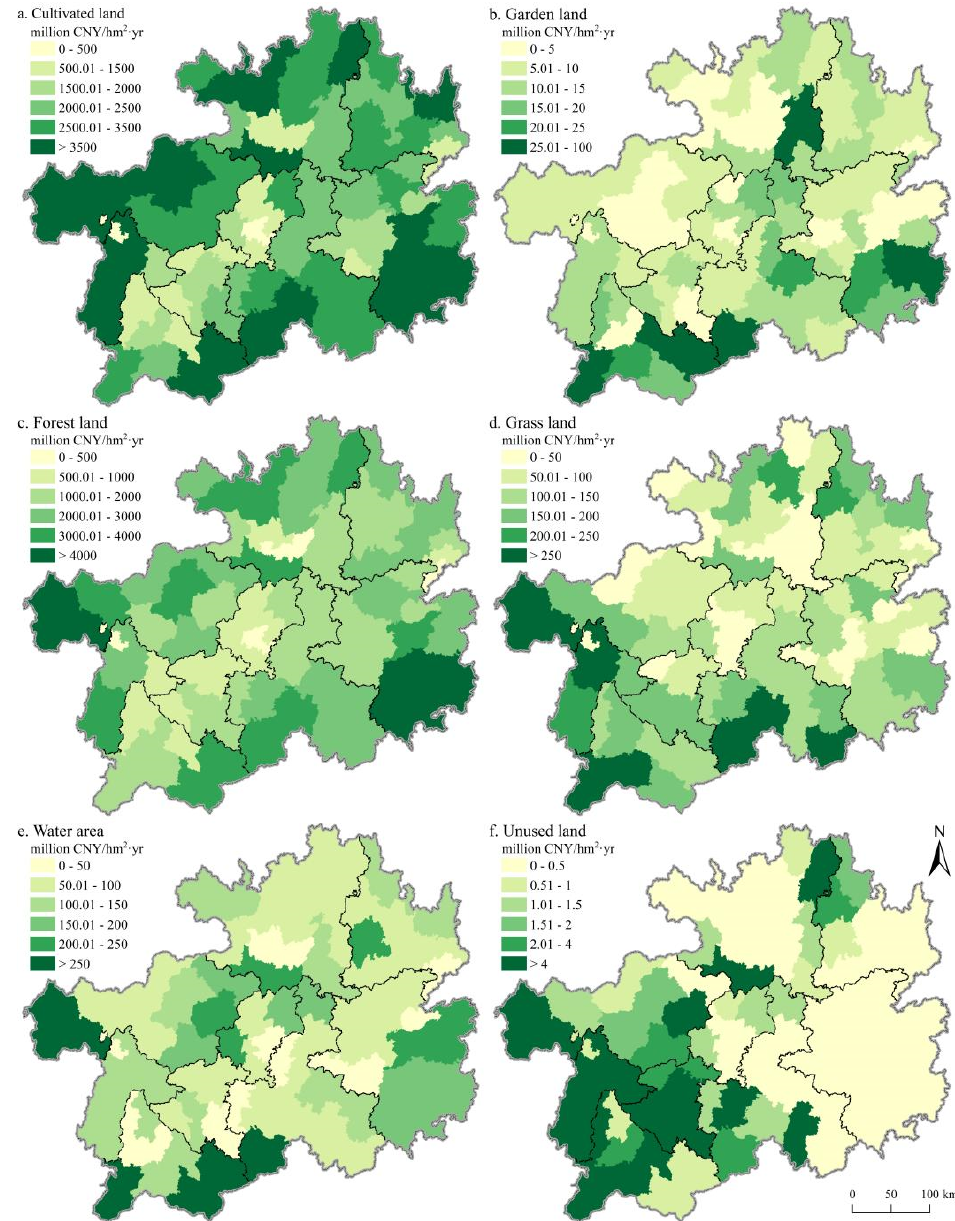
Figure 4. Spatial distribution characteristics of ecosystem services value of different land use types in Guizhou in 2018. Notes: ( a ) the spatial distribution characteristics of ecosystem services value of cultivated land; ( b ) the spatial distribution characteristics of ecosystem services value of garden land; ( c ) the spatial distribution characteristics of ecosystem services value of forest land; ( d ) the spatial distribution characteristics of ecosystem services value of grass land; ( e ) the spatial distribution characteristics of ecosystem services value of water area; and ( f ) the spatial distribution characteristics of ecosystem services value of the unused land.